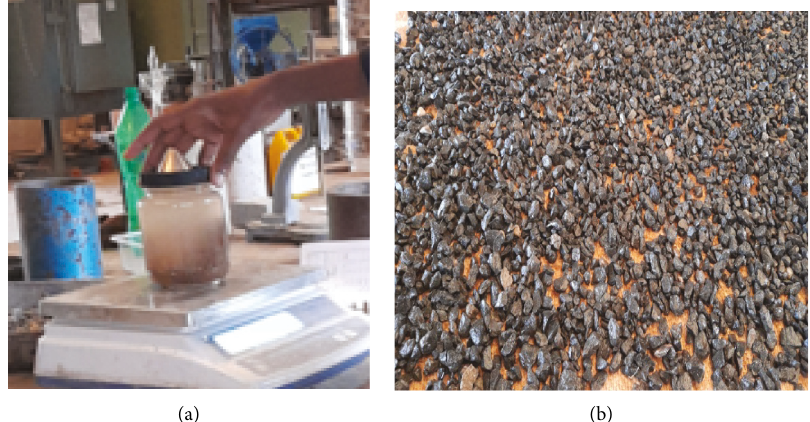
Figure 1: Determination of relative densities of aggregates. (a) Mass of pycnometer with sand. (b) Drying of coarse aggregates.